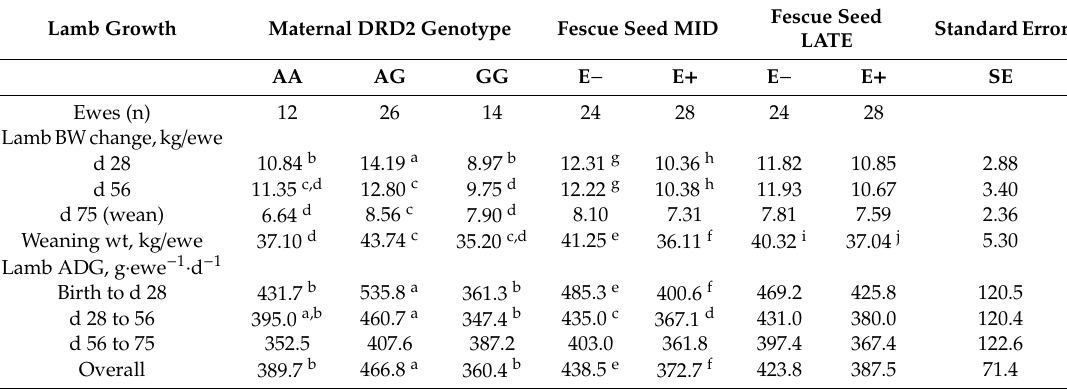
Table 3. Lamb pre-weaning growth by dam genotype, seed and stage of